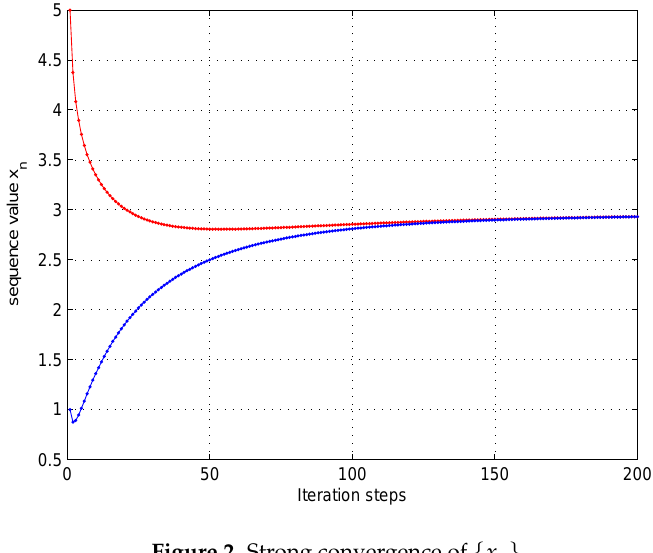
Figure 2. Strong convergence of { x n } . Table 2. The values of the sequence x n